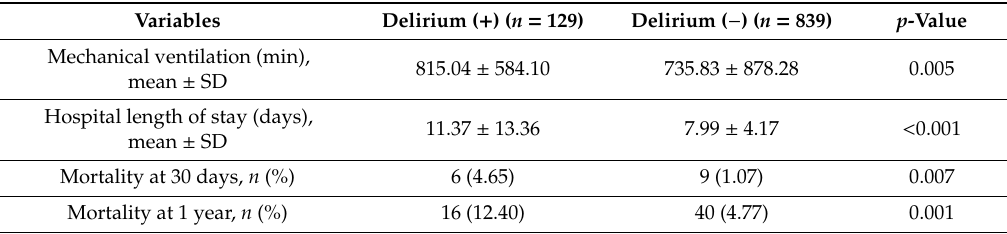
Table 3. Outcome data for patients with and without POD after CABG. POD, Postoperative delirium; CABG, coronary artery bypass grafting.